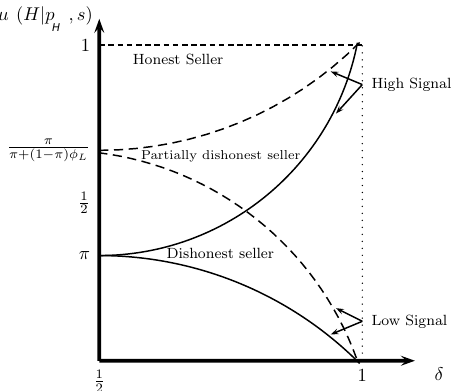
Figure 1. The buyer’s posterior beliefs after receiving a high price offer as a function of her signal realization s , the signal accuracy δ and the low-quality seller strategy φ L , if π < 1